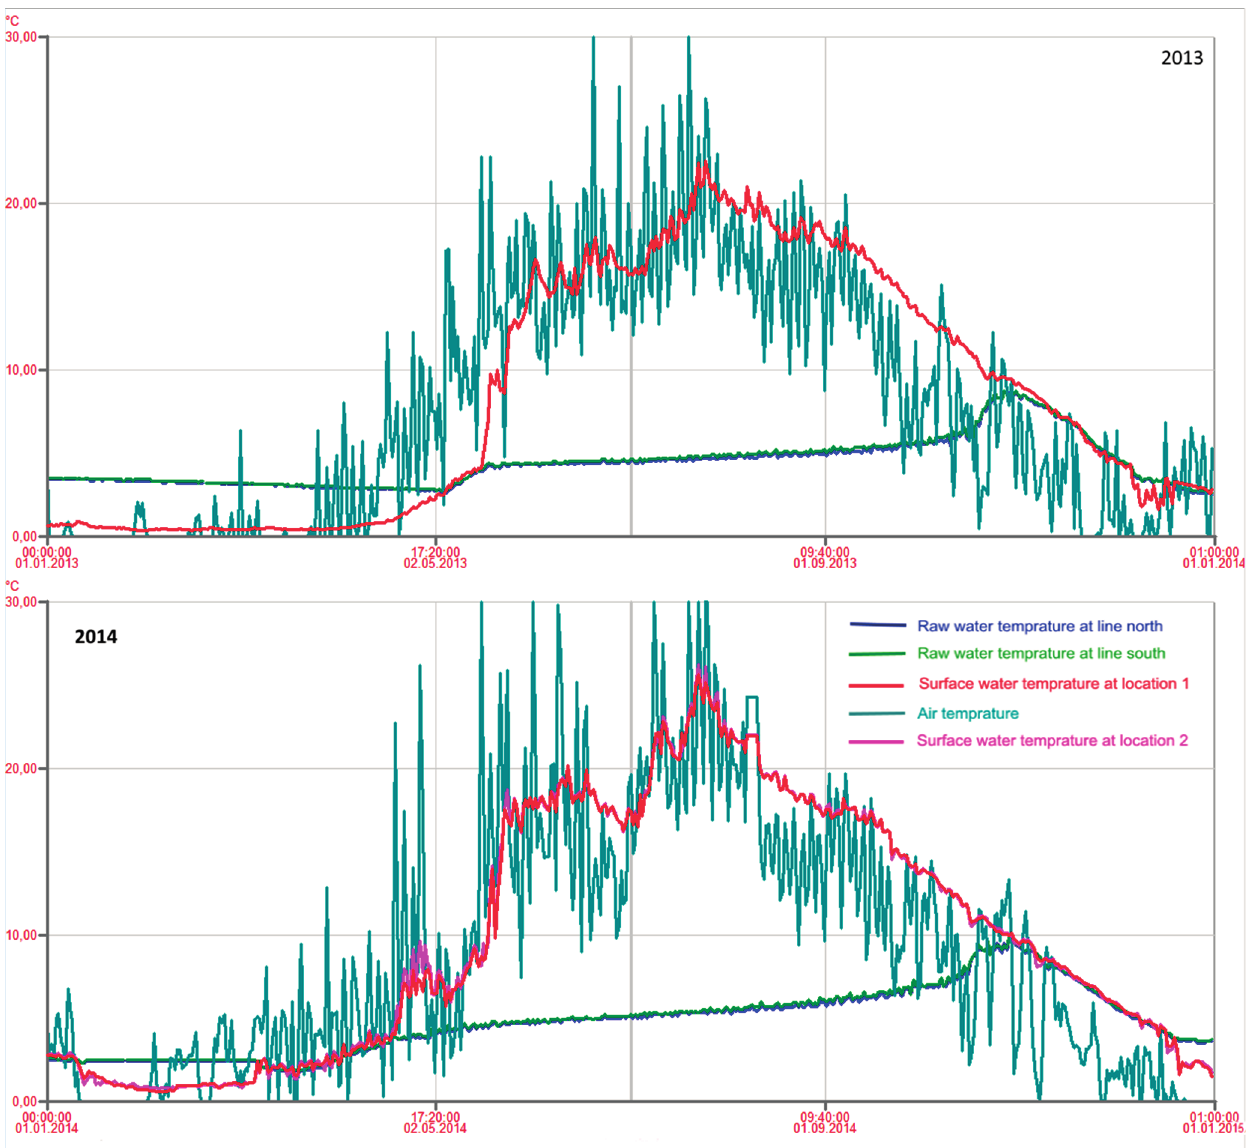
Figure 6. Temperature of raw water from Lake Maridalsvannet (2 different raw water measurements for line north and line south), surface water (at locations 1 and 2) and air temperature for the years 2013 and 2014. The temperature measurements were performed by the Oset water treatment